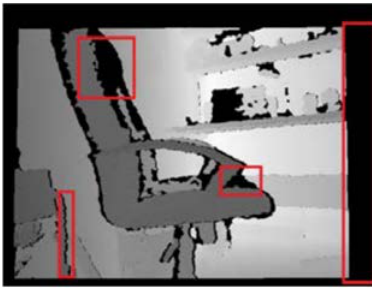
Fig. 3. Depth map with defects.